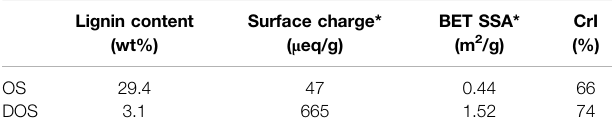
TABLE 1 | Lignin content, surface charge, BET speci fi c surface area (BET SSA) and crystallinity index (CrI) of original olive stone powder (OS) and deligni fi ed olive stone powder (DOS).